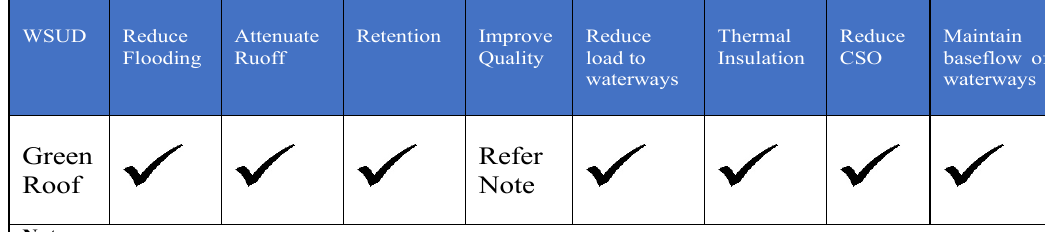
Figure 1. Green roof’s suitability for WSUD.